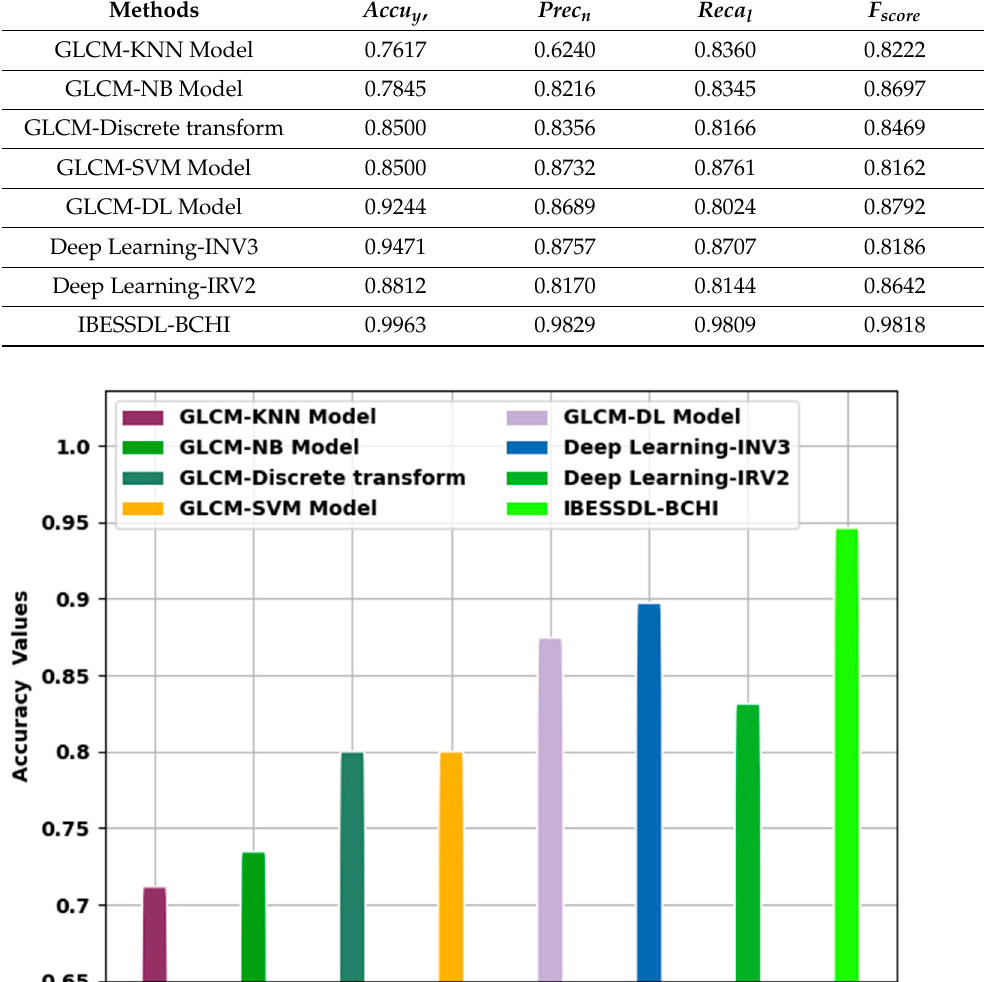
Table 3. Comparative analysis outcomes of the IBESSDL-BCHI approach and other existing ap- proaches using different measures [14,24].